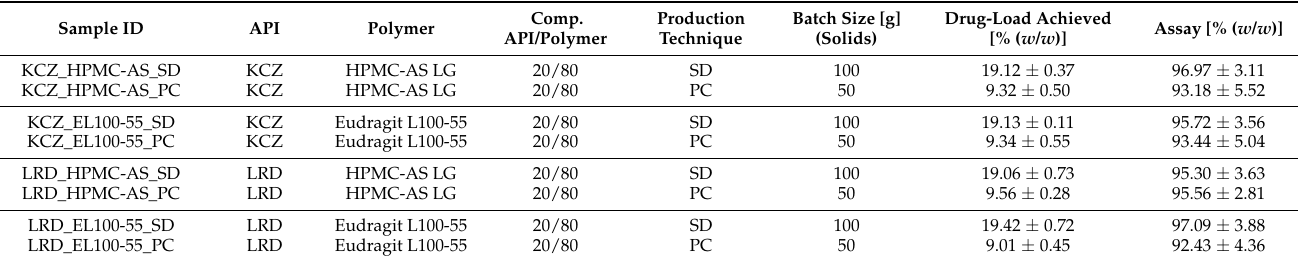
Table 2. Composition of the formulations used production techniques and the API-Yield of the acquired samples ( n =